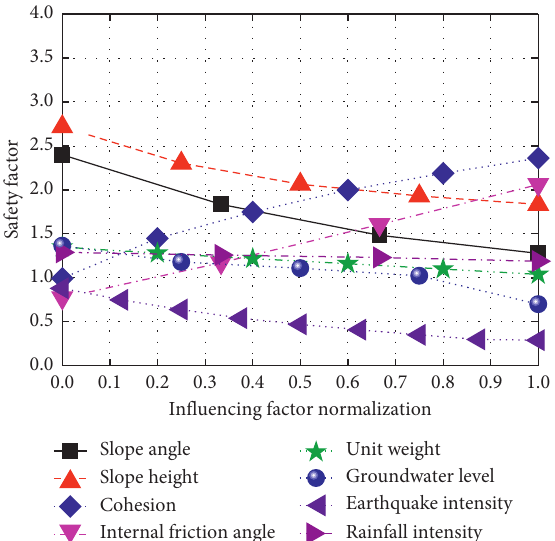
Figure 6: Safety factors under different influencing factors after normalization.